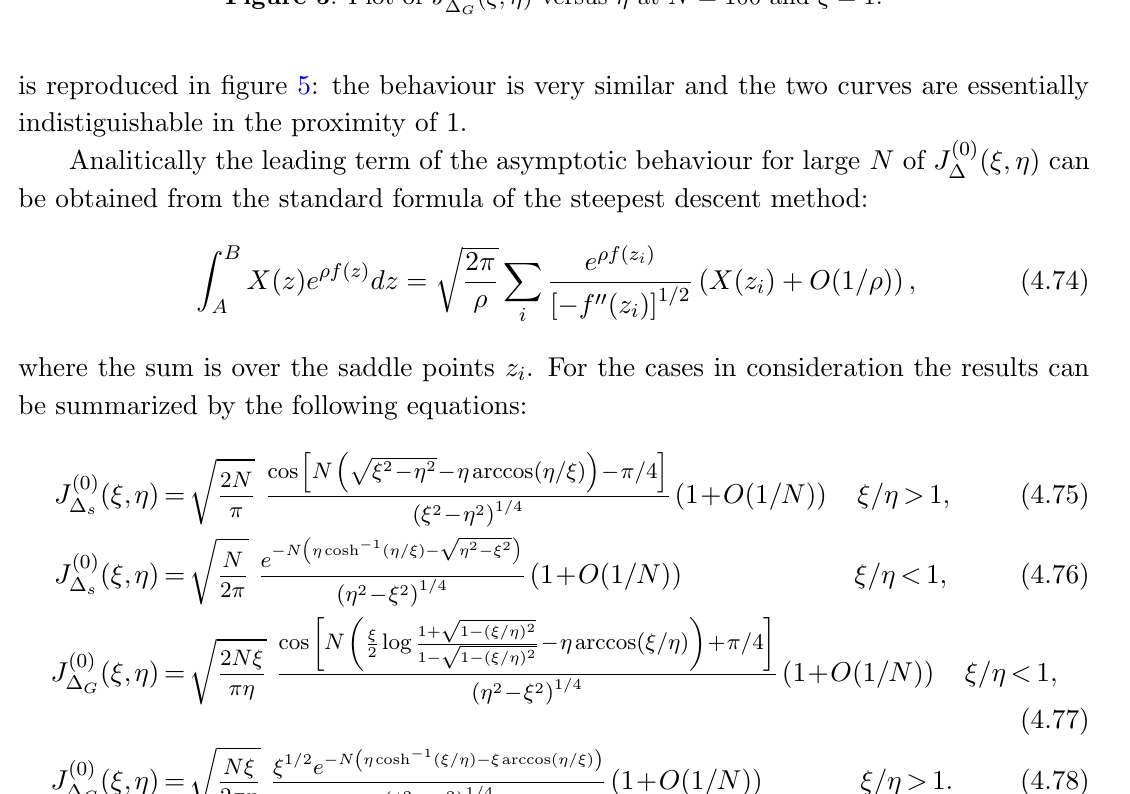
( (cid:24); (cid:17) ) versus (cid:17) at N = 100 and (cid:24) = Figure 5 . Plot of J (0) (cid:1) G